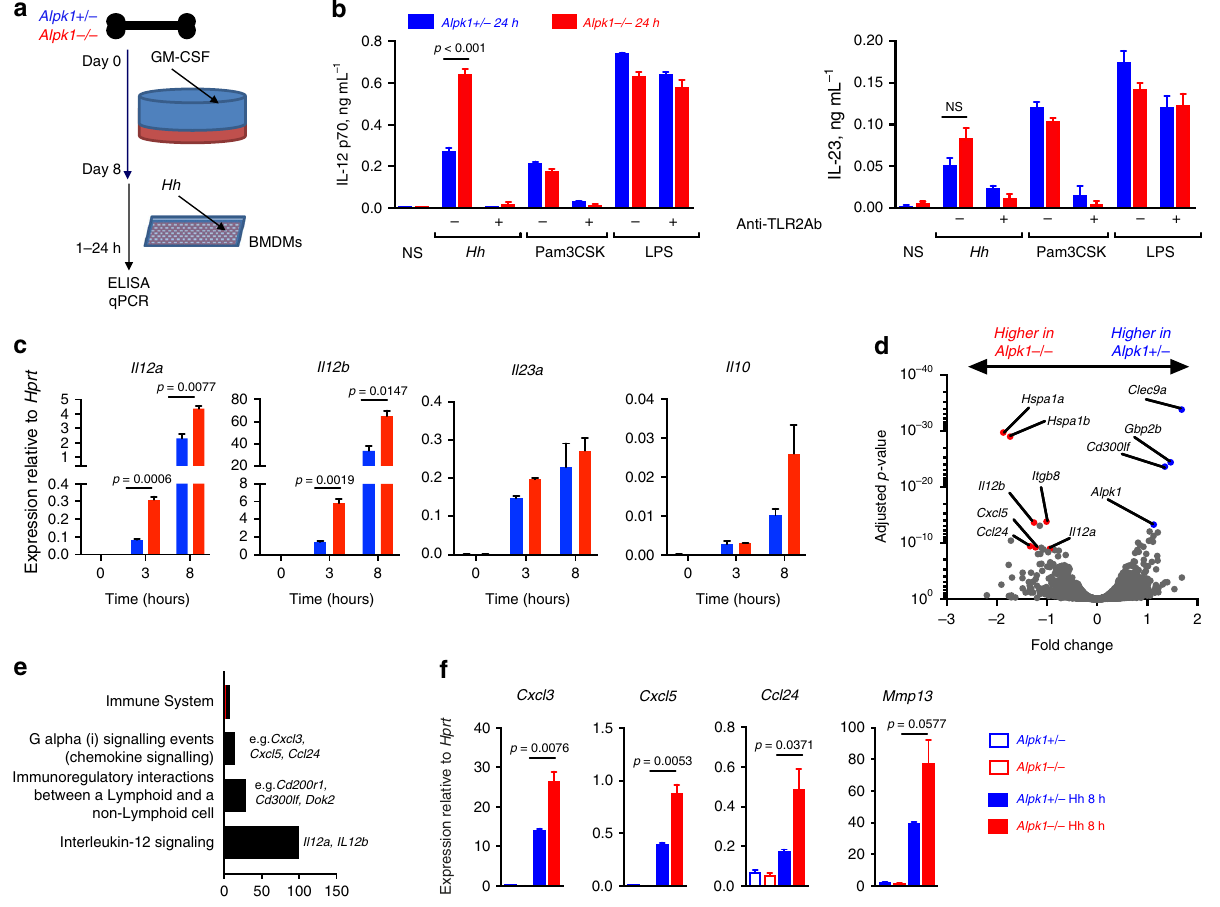
Fig. 5 Alpk1 controls Hh -induced immune gene expression by in vitro differentiated macrophages. a Mouse bone marrow-derived macrophages (BMDMs) were differentiated for 8 days in the presence of GM-CSF for subsequent stimulation with Hh and TLR agonists. b Analysis of IL-12 and IL-23 expression by ELISA. Alpk + / − or Alpk1 − / − BMDMs were stimulated with Hh (0.5 O.D. mL − 1 ), Pam3CSK (100 ng mL − 1 ) or LPS (100 ng mL − 1 ) in the presence or absence of a neutralizing anti-TLR2 (0.3 μ g mL − 1 ) antibody. Data shown are from pooled bone marrows ( n = 3) from one of two independent experiments, data from the Hh -treated group were analyzed by two-tailed unpaired t -test ( t = 12.99; df = 4). Bars indicate mean of three replicates± SEM. c Analysis of gene expression by qRT-PCR of BMDMs stimulated with Hh (0.5 O.D. mL − 1 ) for 3 or 8 h. Data are from pooled bone marrows ( n = 3) from one of three independent experiments. P -values corrected using the Holm-Sidak method are shown. Bars indicate mean of three replicates ± SEM. d Volcano